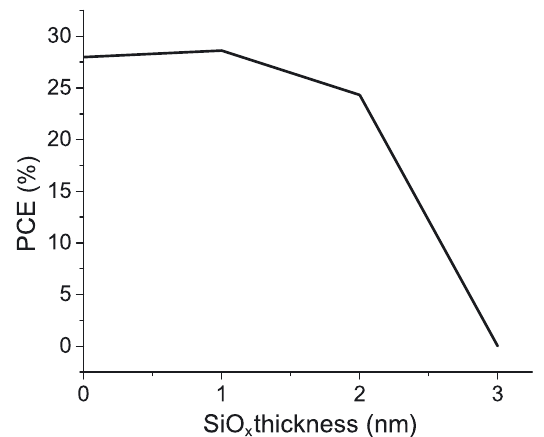
Fig. 4. PCE of InGaN/Si 2-terminal tandem cell as a function of SiO x interfacial layer thickness.